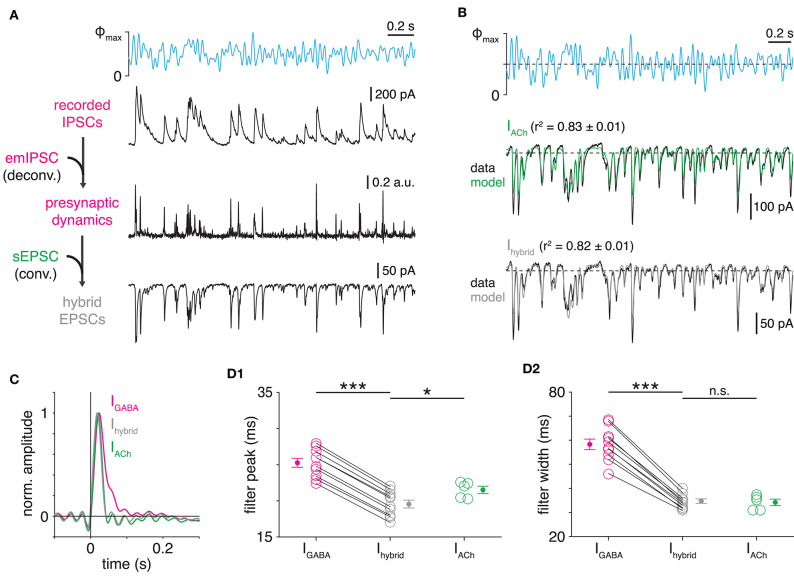
Differential postsynaptic kinetics explain transmitter-specific filtering in SAC→DSGC transmission. (A) Protocol for generation of hybrid PSCs. Wiener deconvolution of ON-OFF DSGC IPSCs removes the contribution of GABAergic postsynaptic kinetics (i.e., emIPSC time course) to estimate presynaptic release dynamics. The result is convolved with an estimate of cholinergic postsynaptic kinetics (i.e., sEPSC time course) to generate hybrid EPSCs. (B) Comparison of recorded and hybrid EPSC responses to optogenetic WN stimulation of SACs. Top, optogenetic WN stimulus. Maximum light intensity (Φmax), 4.8 × 1017 Q cm−2 s−1. Mean responses (black) and LN models (colored) for cholinergic EPSCs recorded in an ON-OFF DSGC (IACh, middle) and hybrid EPSCs (Ihybrid, bottom) combining i) presynaptic dynamics of GABAergic transmission in a different ON-OFF DSGC with ii) postsynaptic kinetics of cholinergic transmission. (C) Comparison of linear filters from recorded PSCs and hybrid EPSCs. Linear filters obtained from GABAergic IPSCs (magenta) and cholinergic EPSCs (green) recorded in separate ON-OFF DSGCs, overlaid with linear filter from hybrid EPSCs (gray) shown in (B). For direct comparison, hybrid EPSC filter shown was generated using the IPSC recording whose filter is overlaid. (D) Peak times (D1) and widths (D2) of linear filters obtained from IPSCs (n = 10 cells) and EPSCs (n = 5 cells) recorded in ON-OFF DSGCs and hybrid EPSCs (n = 10 cells). Linear filter peak time—IGABA vs. Ihybrid: ***p < 0.001, t = 66.4; linear filter width—IGABA vs. Ihybrid: ***p < 0.001, t = 18.0 (paired t-tests). Recorded PSCs analyzed are from Figure 3. *p < 0.05.